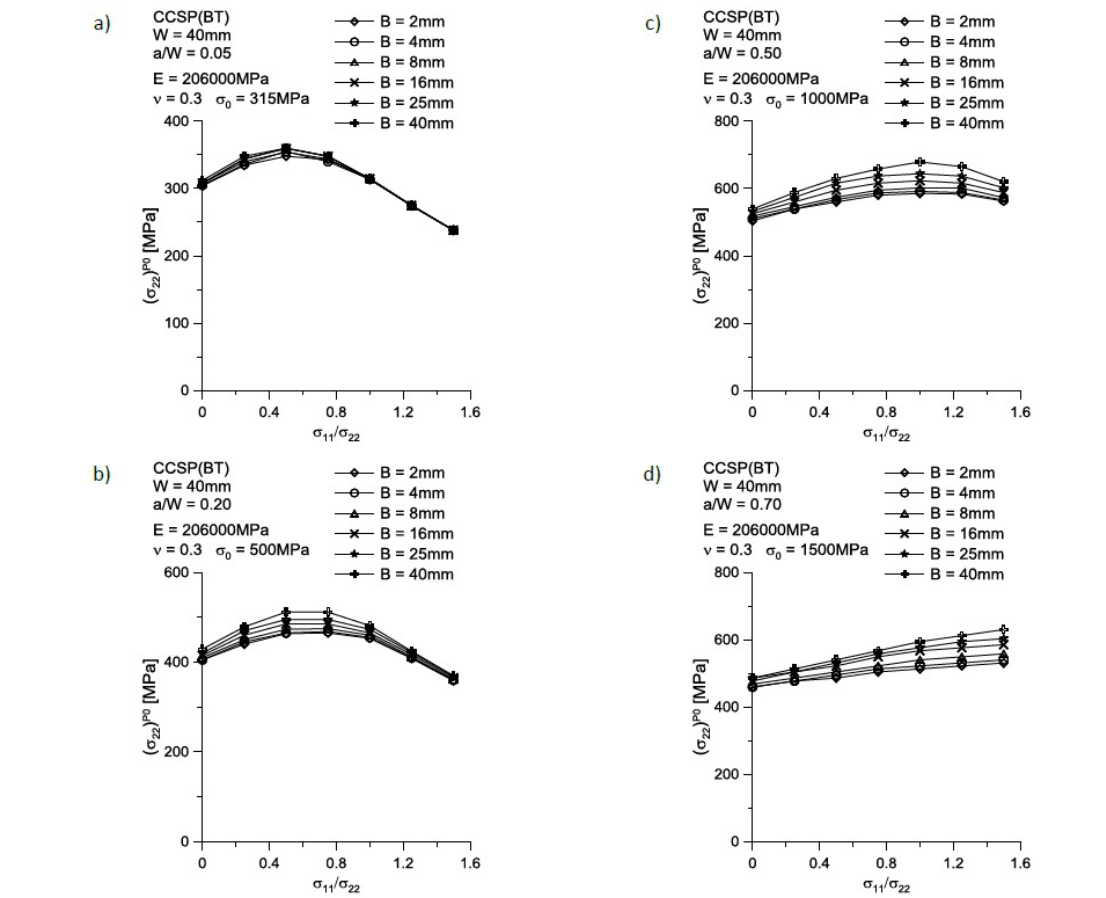
Figure 14: Limit load ( σ 22 ) P 0 vs. ratio σ 11 / σ 22 for three-dimensional cases at fixed yield strength and relative crack